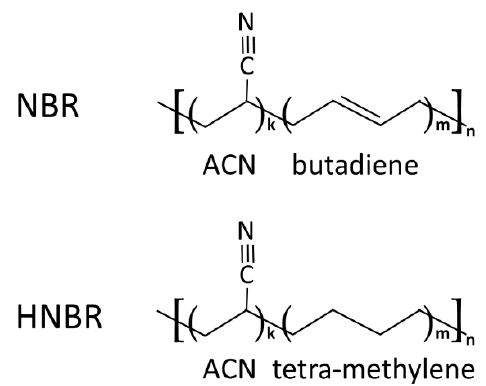
Figure 1. Simplified chemical structure of nitrile-butadiene copolymer (NBR) and fully hydrogenated NBR (HNBR). In each acrylonitrile (ACN)-butadiene or ACN-tetra-methylene sequence, k and m are random numbers.